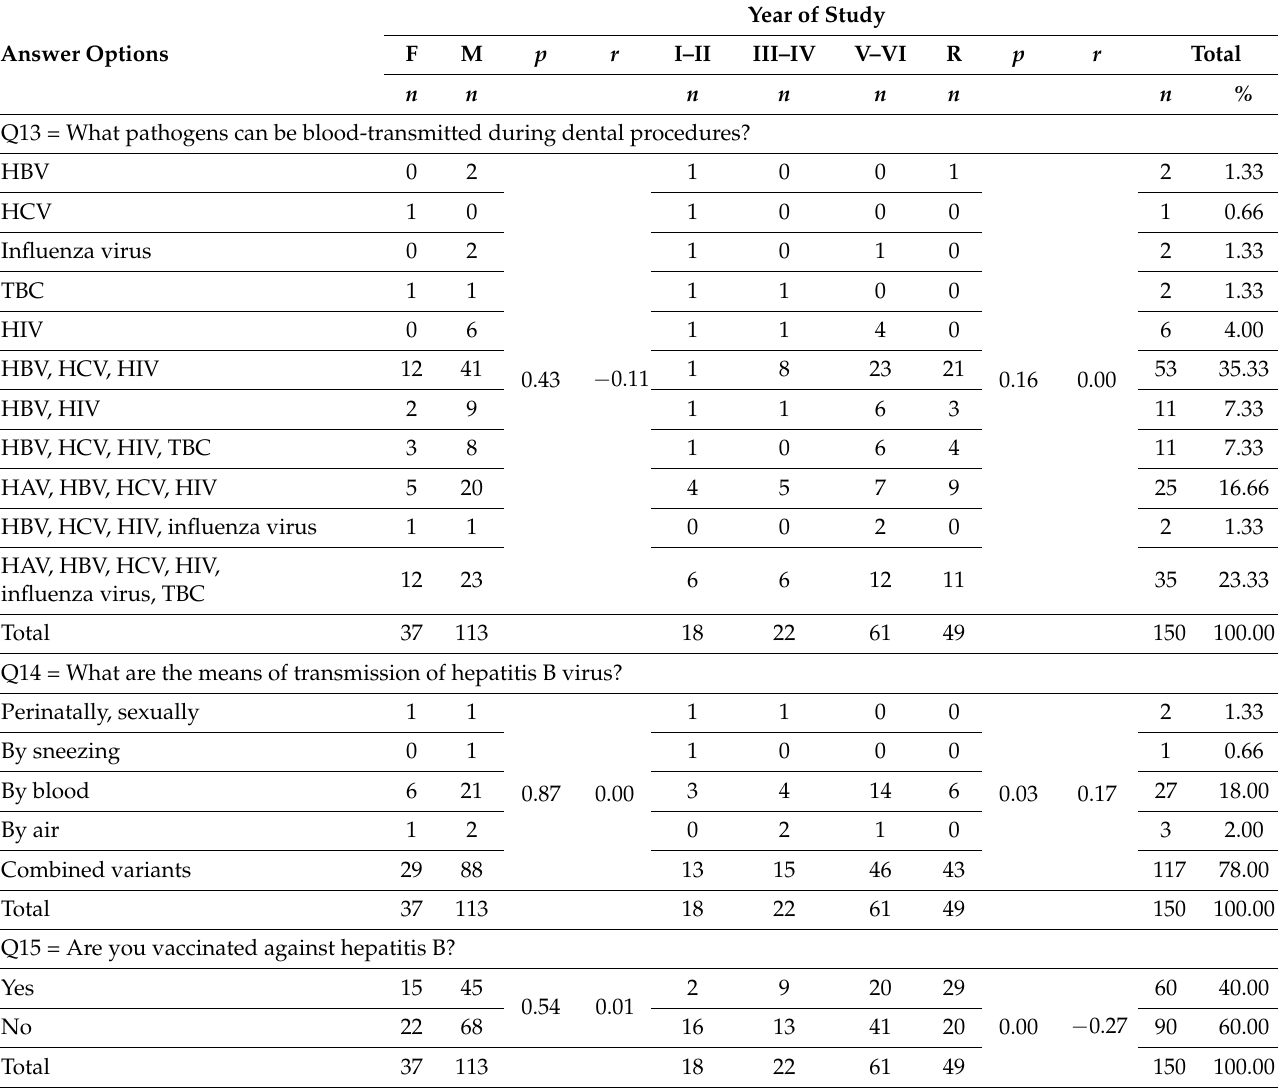
Table 5. Frequency distribution of answers to the questions about bloodborne infection control by gender and year of